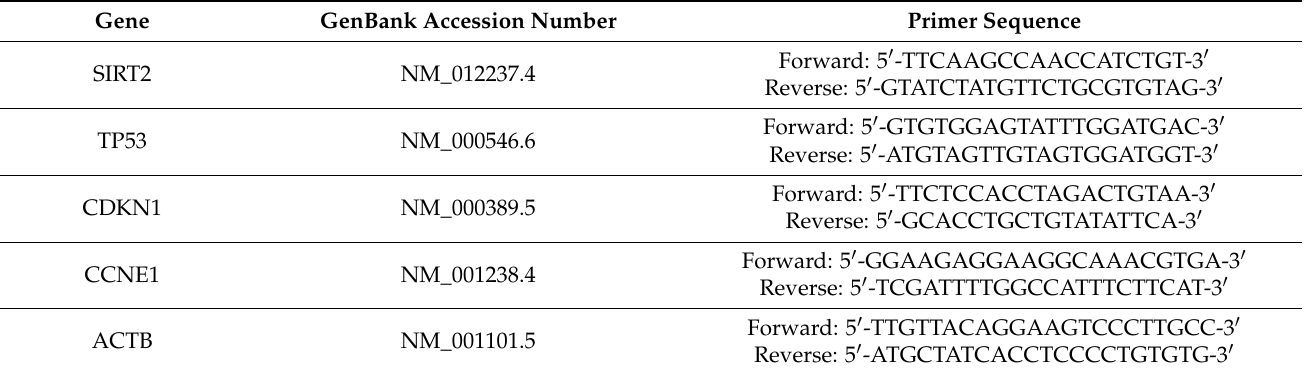
Table 1. Oligonucleotide primer sequences used for the quantitative real-time PCR